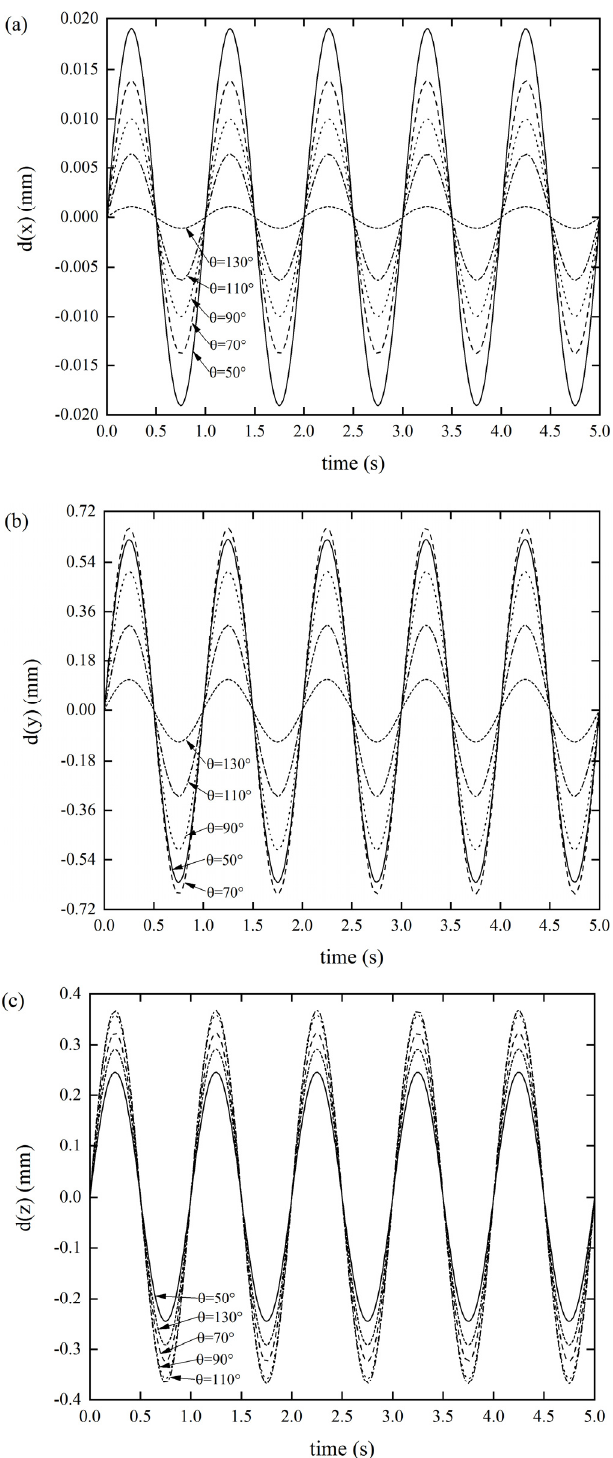
Figure 6. DDR of the Miura tube when folding angle θ varies( t = 0.6 mm, a/b = 1) ( a ) x -displacement of the Miura tube under force along the x -direction, ( b ) y -displacement of the Miura tube under force along the y -direction, and ( c ) z -displacement of the Miura tube under force along the z -direction.